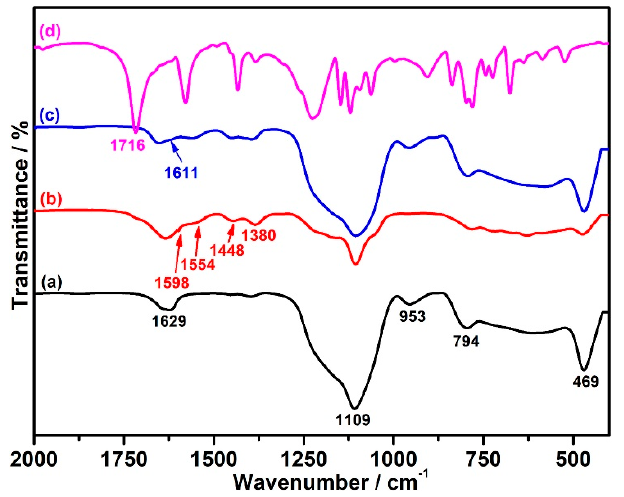
Figure 1. FT-IR spectra of ( a ) SiO 2 @mTiO 2 , ( b ) SiO 2 @mTiO 2 -bpdc, ( c ) Eu(tta) 3 bpdc-SiO 2 @mTiO 2 and ( d ) H 2 bpdc ligand.